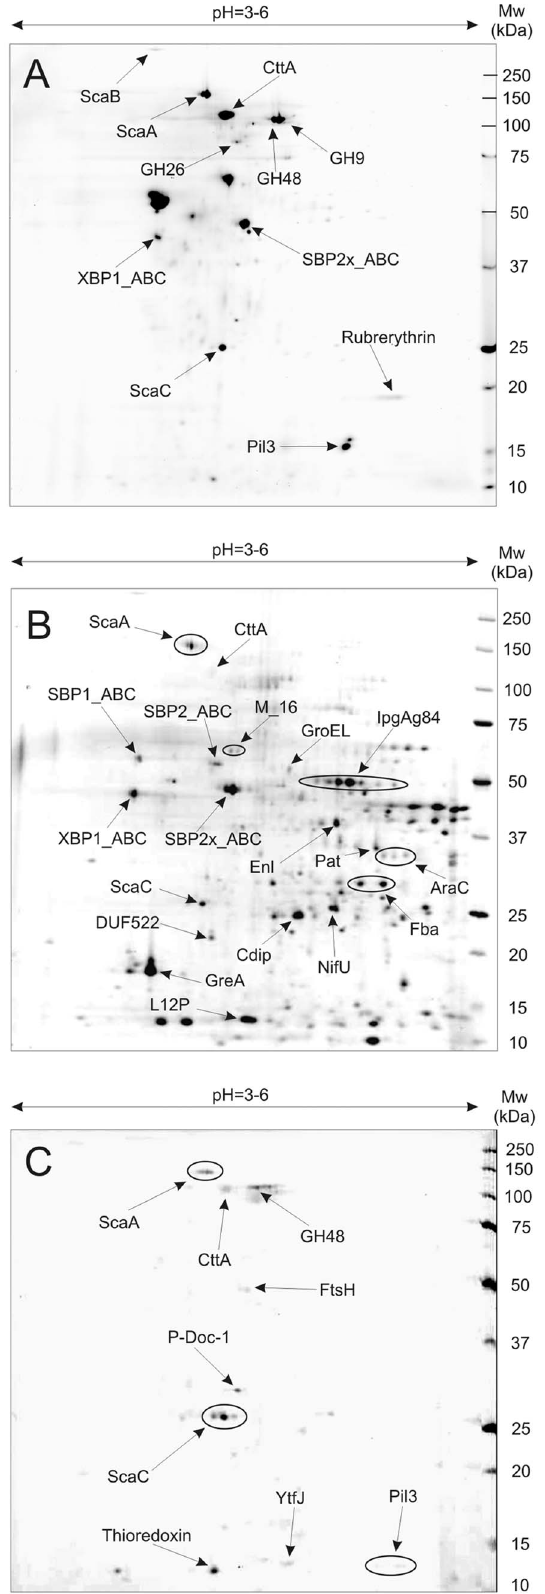
Figure 1. Proteome of cellulose-grown Ruminococcus flavefa- ciens 007C. Showing 2D gel separations of: A) cell culture supernatant (CCSUP) protein fraction, B) cell wall associated (CWAP) fraction (following growth on Avicel for 7.5 days); C) cellulose-bound (CBP) fraction following growth on dewaxed cotton for 9.5 days. Abbrevia- tions: Pil3 - protein with type IV pilin N-terminal domain (encoded by pil3 ), P-Doc-1 - protein with dockerin type-1 (no other conserved domains/signature sequences have been detected), GH -